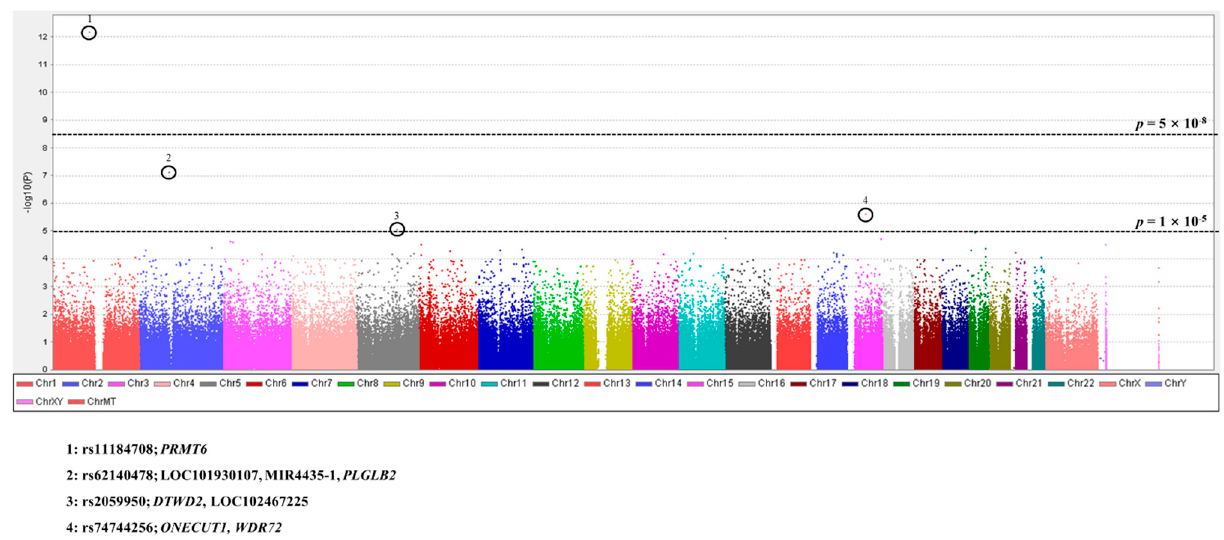
Figure 1. Manhattan plot of the strength of association between scrub typhus-infected patients and healthy age- and sex-matched controls. Y axis: − log10( p ) values; X axis: chromosomal position. Dotted lines indicate two thresholds of potent association with p value = 1 × 10 − 5 and p value = 5 × 10 − 8